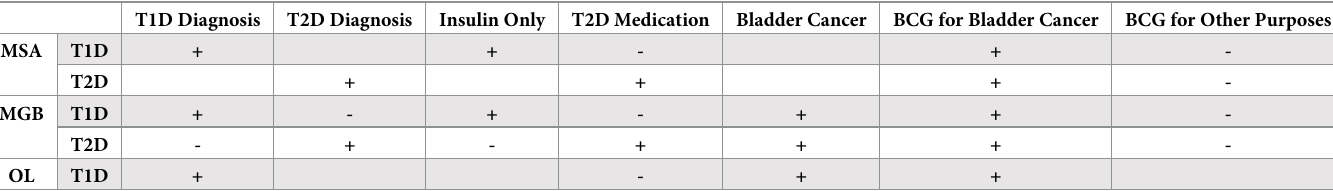
Table 1. Search criteria for data from various data